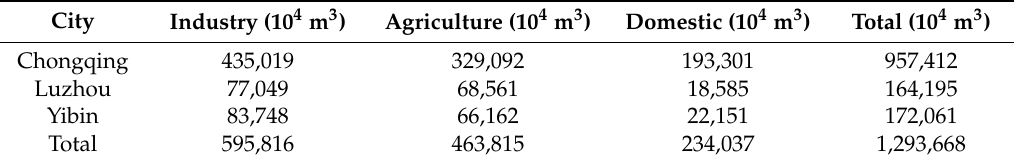
Table 4. Social and economic water demand in the study